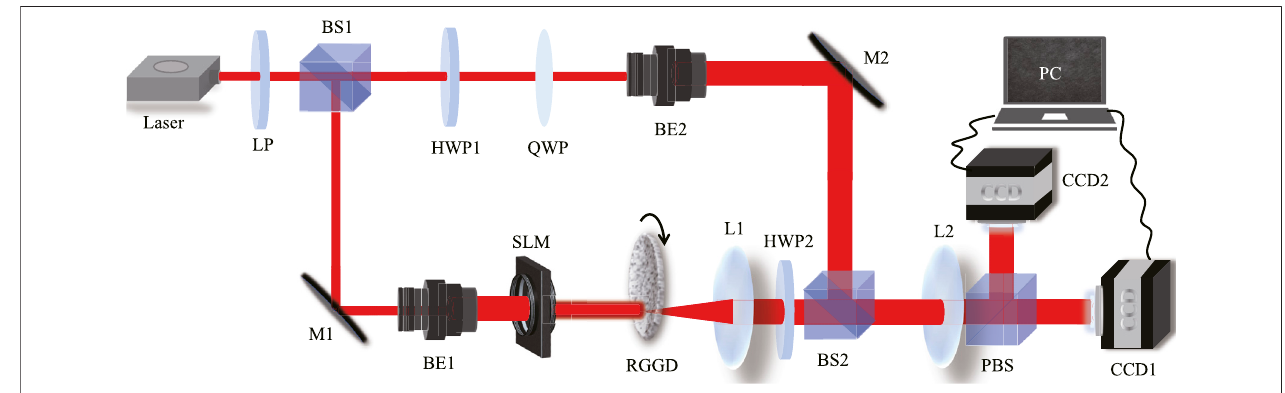
FIGURE2| Experimentalsetupforopticalimagingthrougharandomscatteringmediumviathecomplexspatialcoherencemeasurement.LP:linearpolarizer;BS1 and BS2: beam splitters; HWP1 and HWP2: half-wave plates; QWP: quarter-wave plate; BE1 and BE2: beam expanders; M1 and M2: mirrors; SLM: spatial light modulator; RGGD: rotating ground-glass disk; L1 and L2, thin lenses; PBS: polarization beam splitter; CCD1 and CCD2: charge-coupled devices; PC: personal